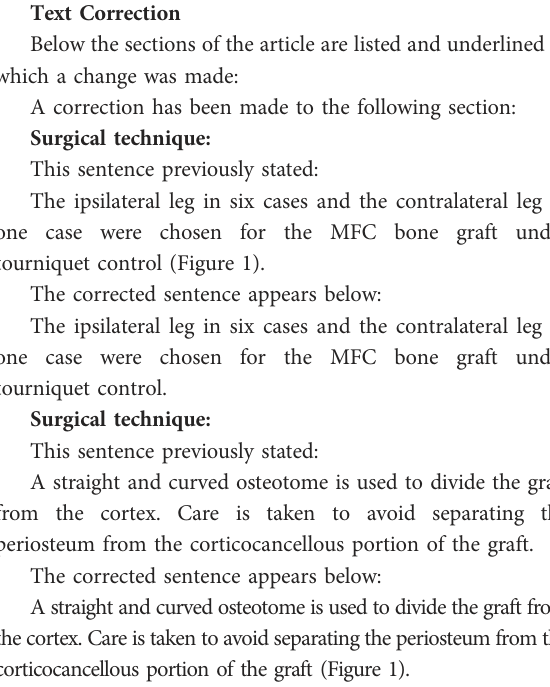
bone graft; ICG, indocyanine green; NIR, near-infrared.